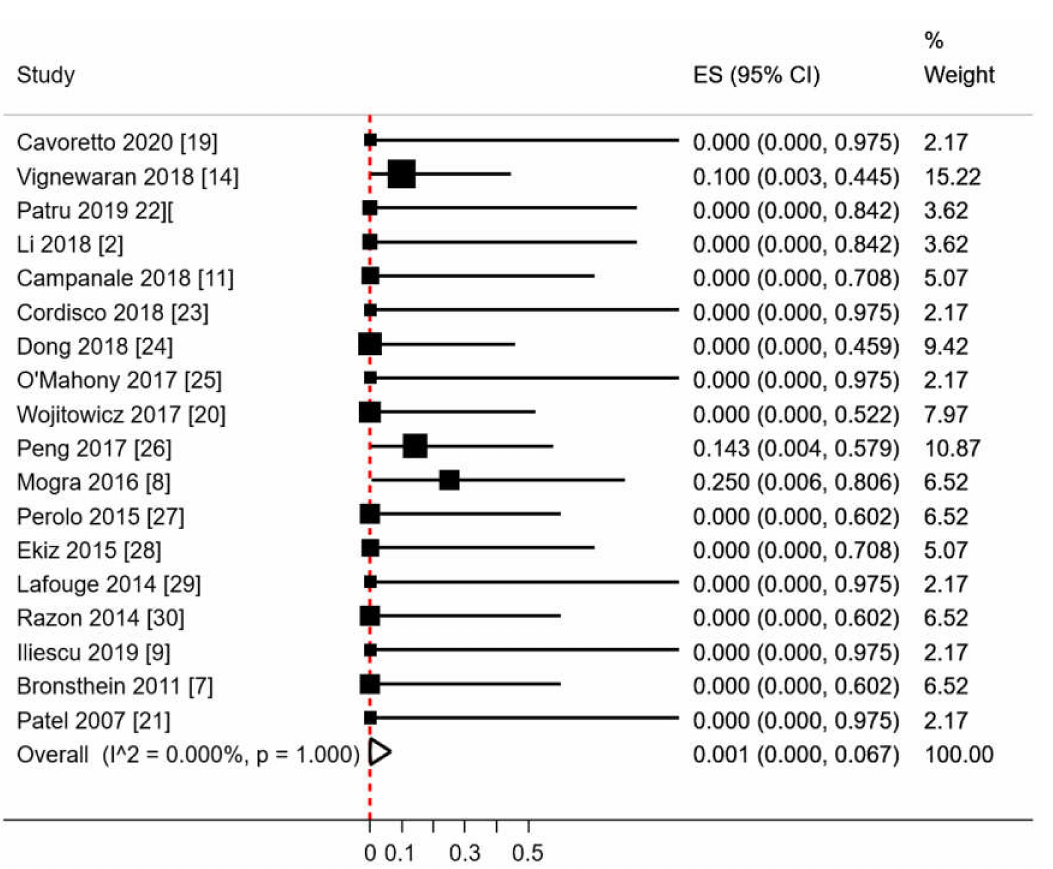
Figure 5. Pooled proportion of aberrant left subclavian artery in RAA / RDA fetuses. ES: e ff ect size. CI: confidence interval. Red dashed line describes the e ff ect estimate found in the present analysis. Iˆ2: I 2 of Higgins.